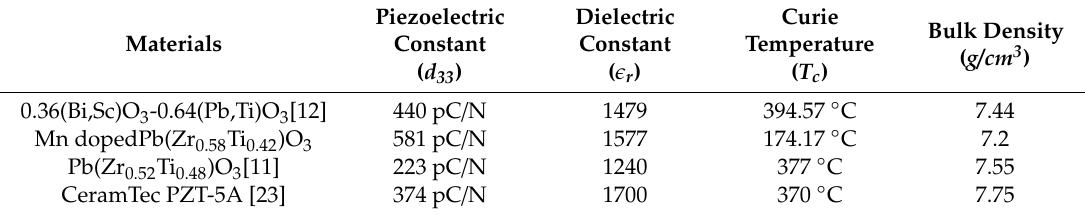
Figure 2. Temperature-dependent relative dielectric constant ε r of 0.36(Bi,Sc)O 3 -0.64(Pb,Ti)O 3 and Pb(Zr 1- xTix)O 3 (PZT) ceramics. Table 1. Characteristics of the prepared 0.36(Bi,Sc)O 3 -0.64(Pb,Ti)O 3 (BS-PT).